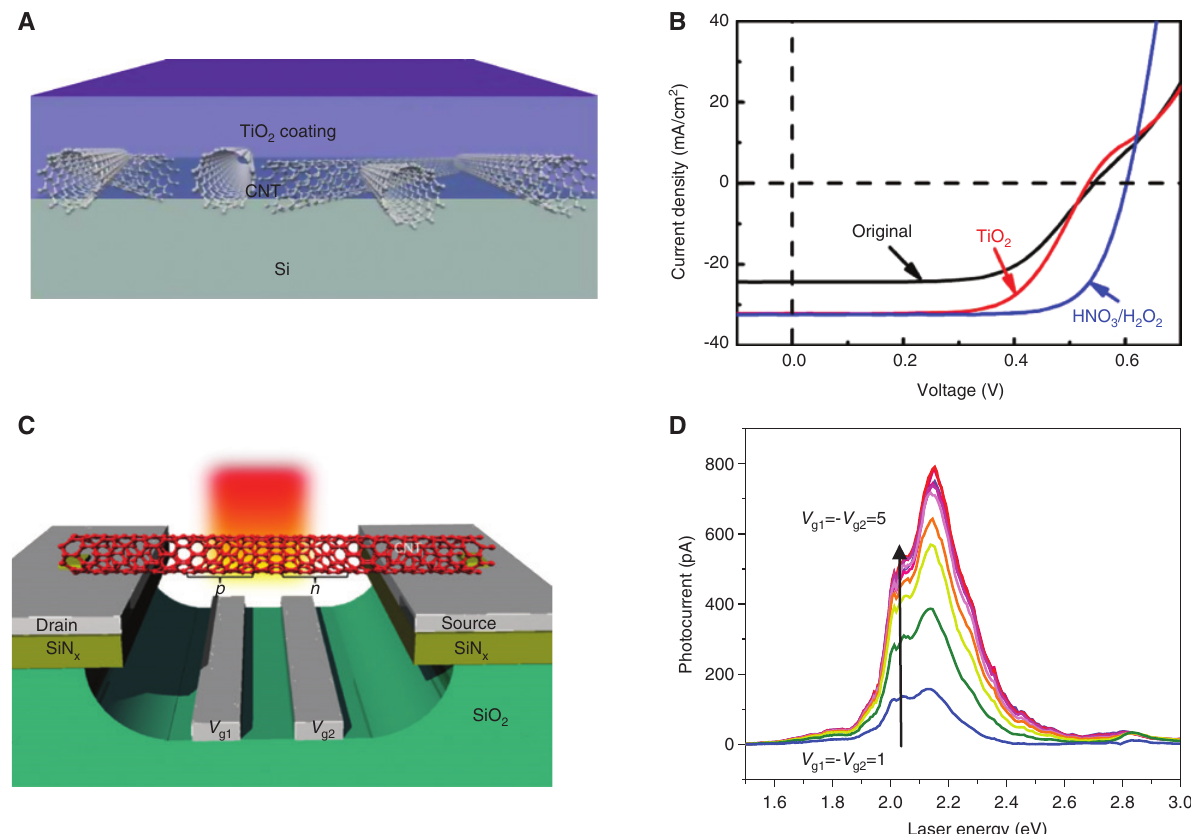
layer as an antireflection coating layer. (B) The measured 2 /H O doping and TiO coating [53]. 3 2 2 2